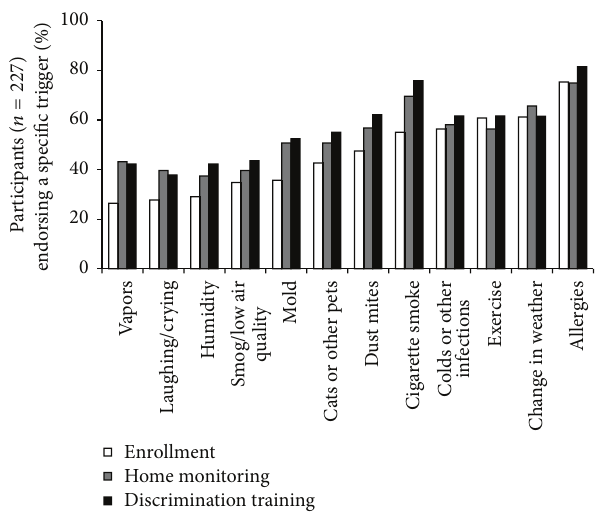
Figure 1: Trigger identification at enrollment, after home monitor- ing, and after discrimination